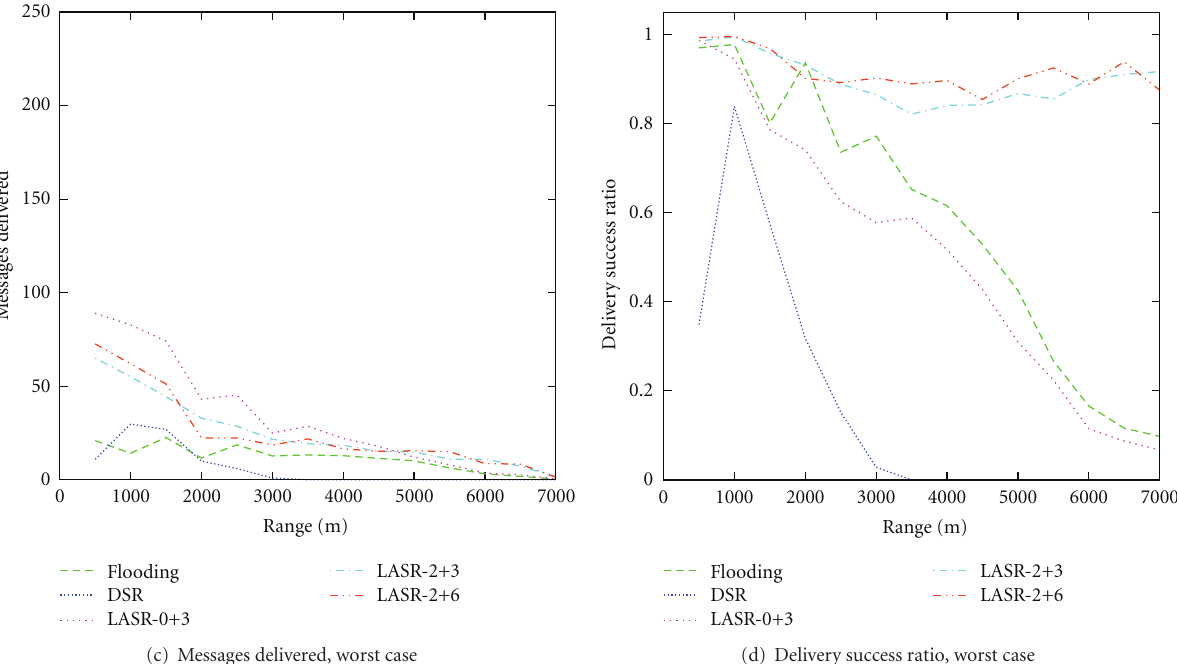
Figure 7: Messages delivered and message success: 16-vehicle spiral, FER NN ,max = 0 .